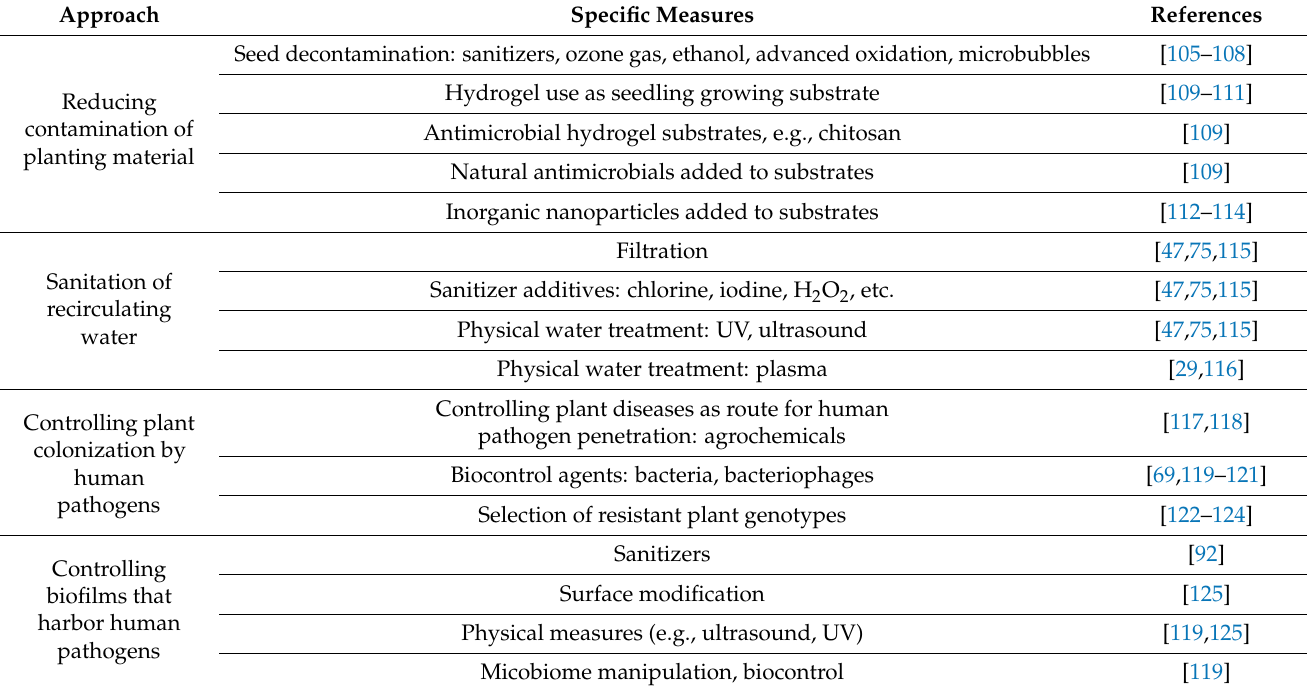
Table 3. Approaches to mitigating microbial contamination in hydroponically grown crops. Specific